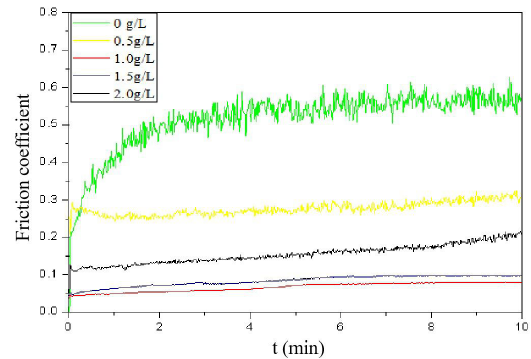
addition on the friction coefficient of 2